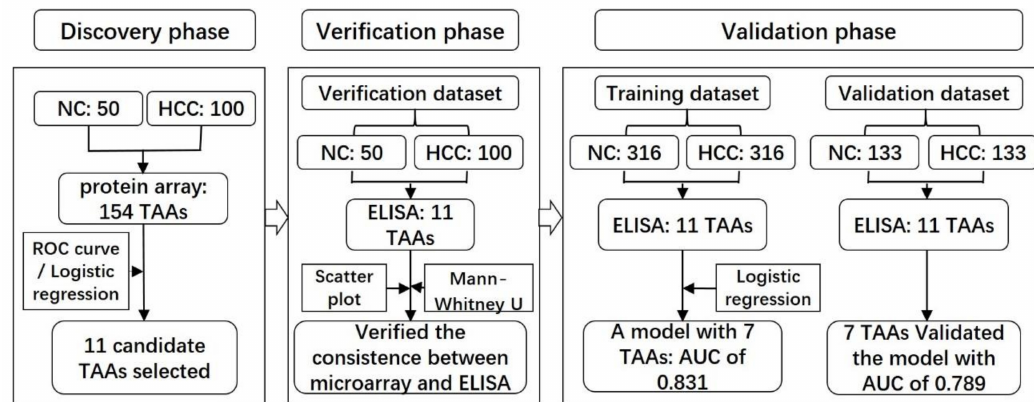
Figure 1. Workflow chart of the study. A total of 150 samples were used to screen potential biomarkers in the discovery phase and further applied in the verification dataset to verify the results of the protein microarrays. Another 898 participants were included in the validation phase, 632 of which were used to validate the previous results and to build a predictive model for HCC named as the training dataset, while the other 266 participants were recruited to validate the model named as the validation dataset. HCC, hepatocellular carcinoma; NC, normal control.